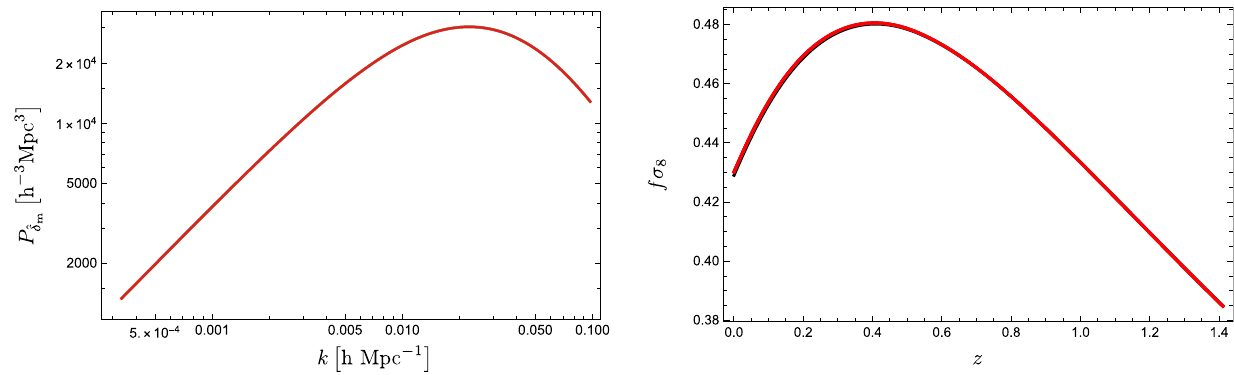
Fig. 1 The left panel of this figure represents the matter power spectrum while the right panel shows the evolution of f σ 8 in terms of the redshift z . All models with different values of c 2